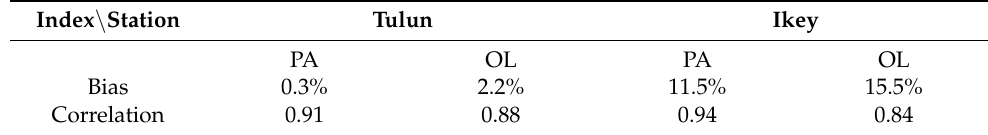
Table 3. Validation of open loop (OL) and after assimilation (PA) with respect to in situ measurement.